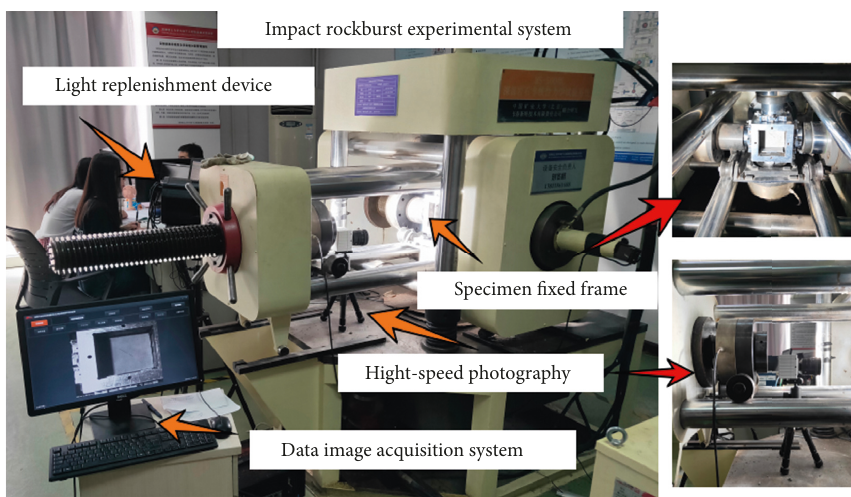
Figure 13: Experimental